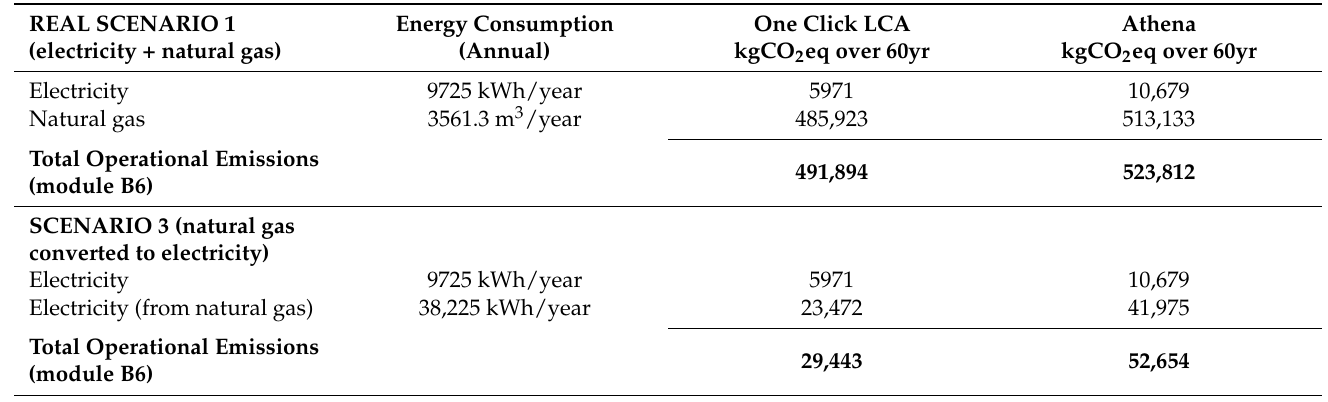
Table 9. Energy consumption and operational emissions for the Single-detached house (scenarios #01 and